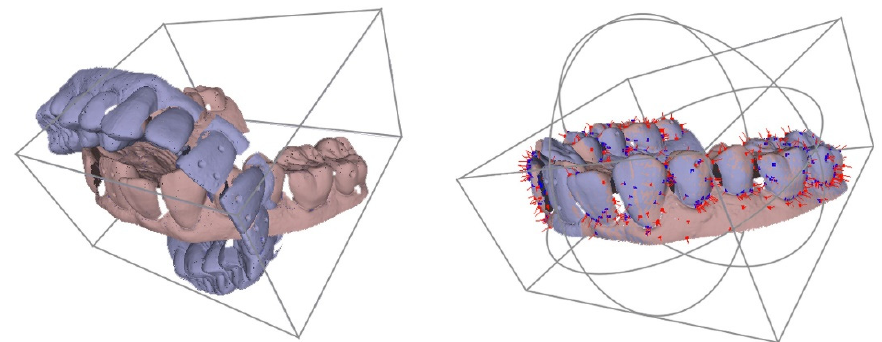
Figure 2. Software-based superimposition of comparison model (orange) and setup model (blue) using MeshLab’s “Align Tool” and reference points.